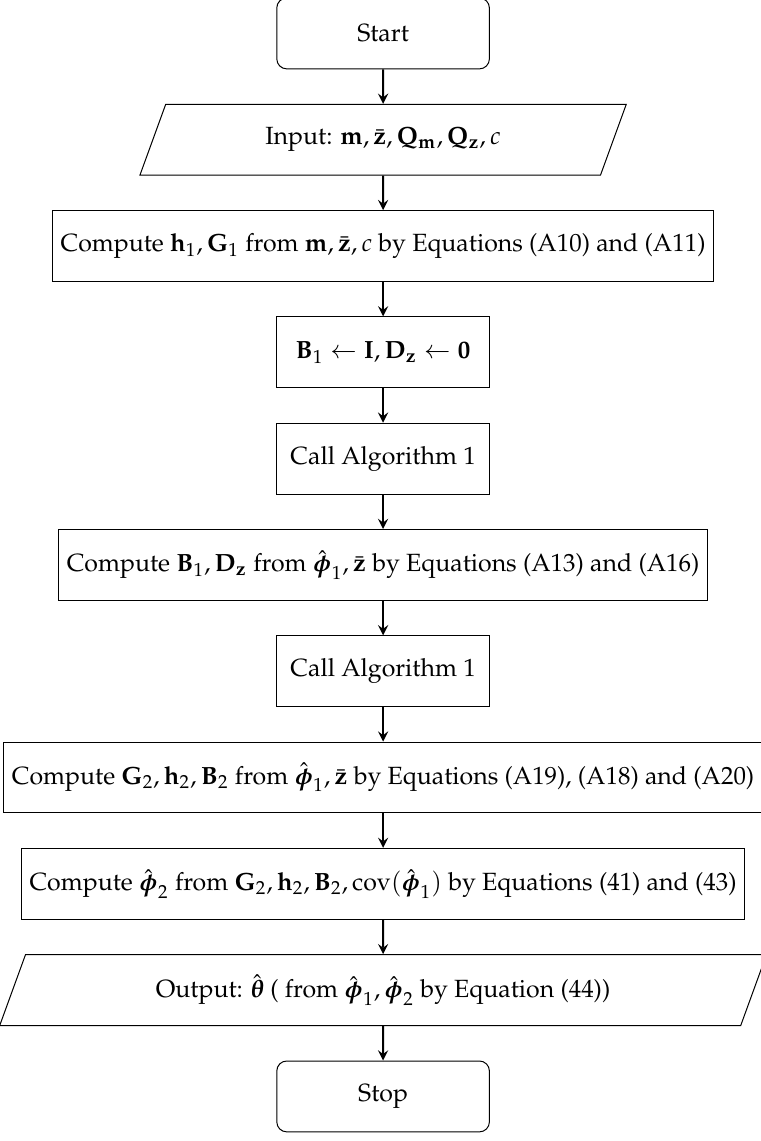
Figure 1. Flowchart of the proposed estimator. Algorithm 1 is called in the flowchart.